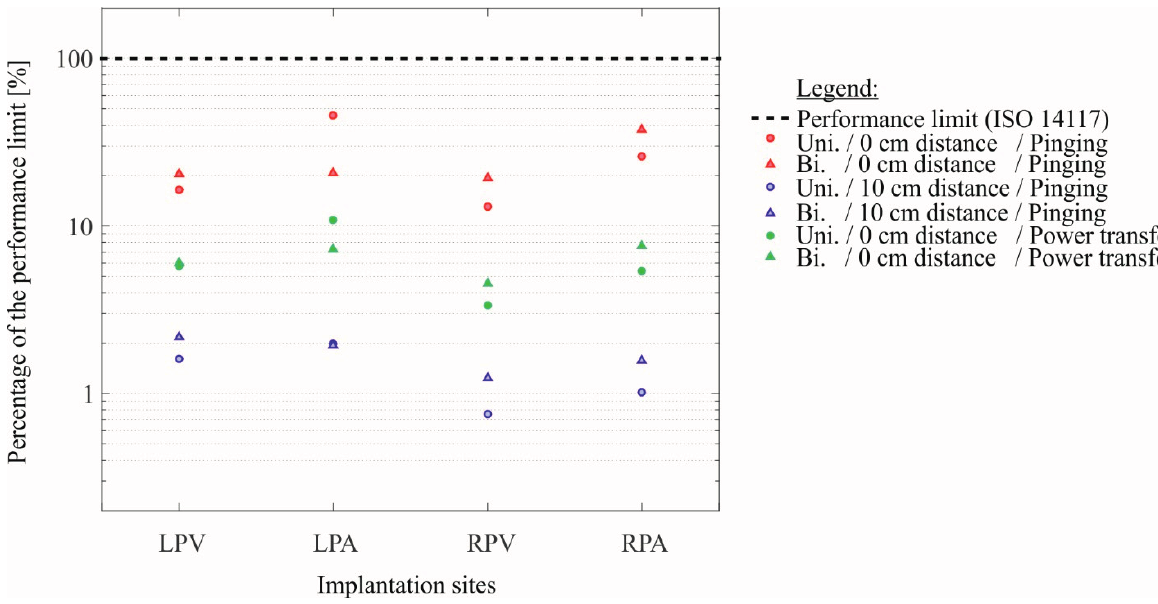
Figure 6. The percentage portion of the performance limits of ISO 14117 contextualized with the most EMI affecting parameters: the four implantations sites, the two lead types and the two operating modes of the Qi-A13-Board. Additionally the attenuation of the induced voltage at 10 cm distance is presented (compare red and blue